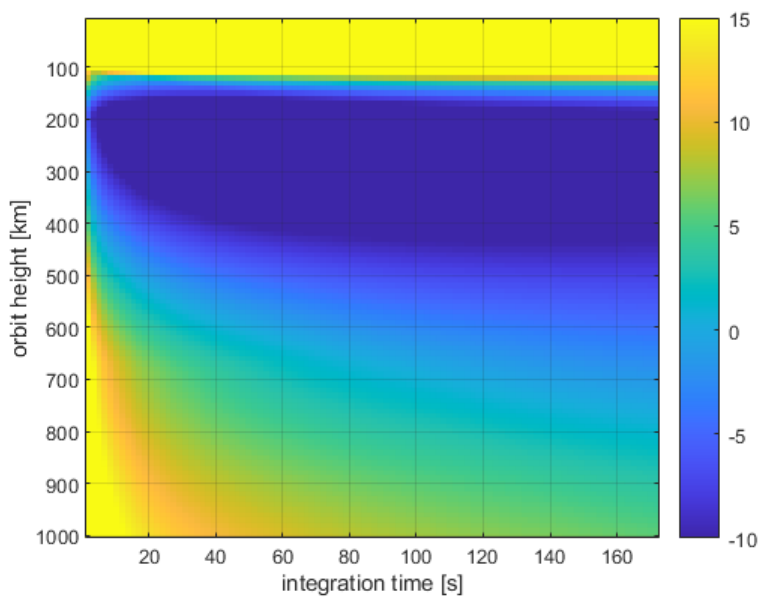
Figure 18. Detected target cross-section in dBsm versus integration time and orbit